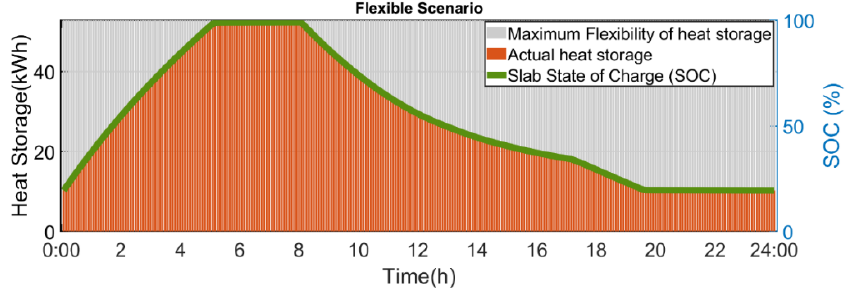
Figure 18. Heat storage and state of charge (SOC) of the slab (flexible case).